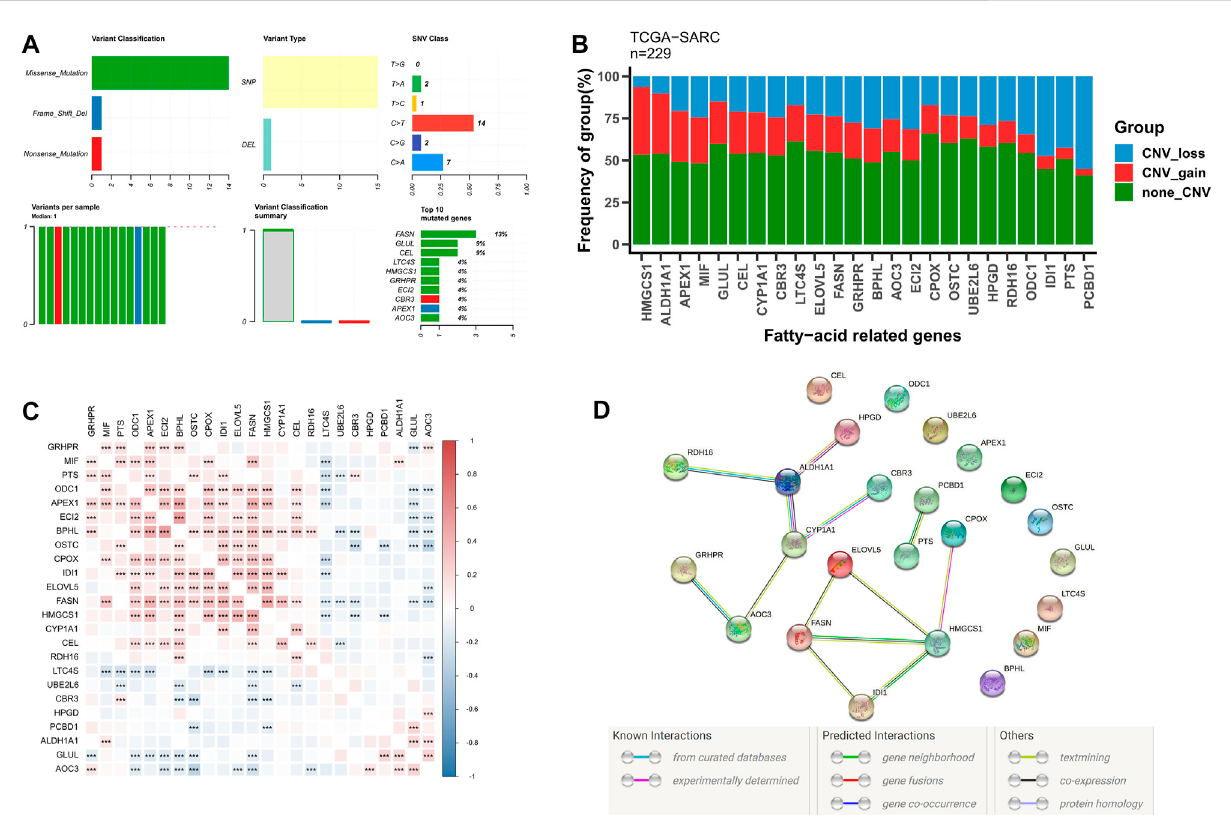
FIGURE 2 The genetic alterations and association of fatty acid metabolism-related genes in STS. (A) The somatic mutational status of 24 candidate fatty acid genes in STS. (B) The frequencies of CNV gain, loss, and non-CNV among fatty acid genes. (C) Heatmaps illustrating patterns of fatty acid gene coexpression. (D) PPI network map of fatty acid genes using